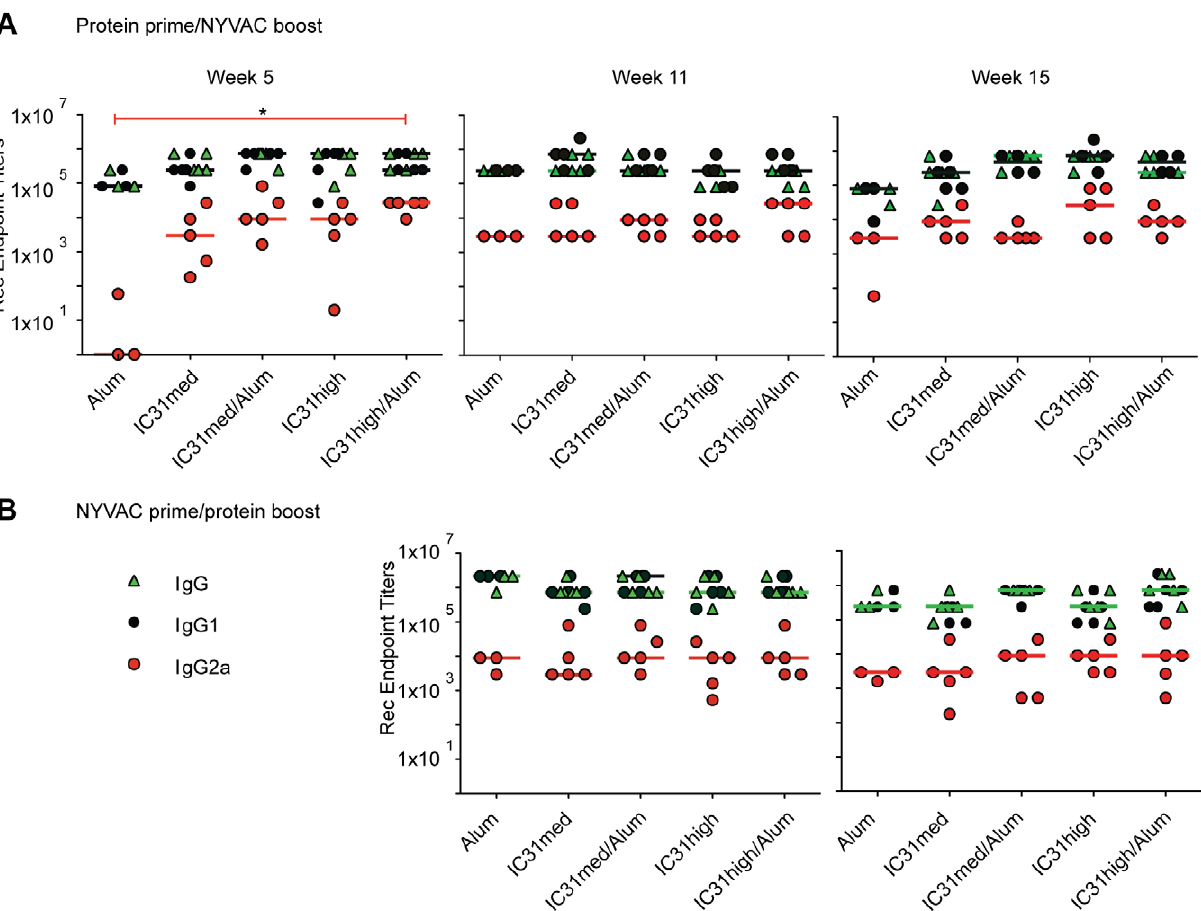
Figure 2. Robust antibody responses are induced by all vaccination regimens. Serum levels of total IgG (green triangles), IgG1 (black circles) and IgG2a (red circles) were measured at weeks 5, 11 and 15. A) Mice were primed at weeks 0 and 3 with Env-CN54 gp140 with alum alone, or a medium (‘‘med’’) or high concentration of IC31 with or without alum, and boosted at week 6 and 9 with NYVAC-CN54. B) Mice were primed at weeks 0 and 3 with NYVAC-CN54 and boosted at week 6 and 9 with Env-CN54 gp140 protein in combination with the adjuvants as indicated. Total IgG could not be detected in the control mice. The graphs show the antibody titers detected by ELISA at weeks 5, 11, and 15. Bars correspond to the medians. *p , 0.05.